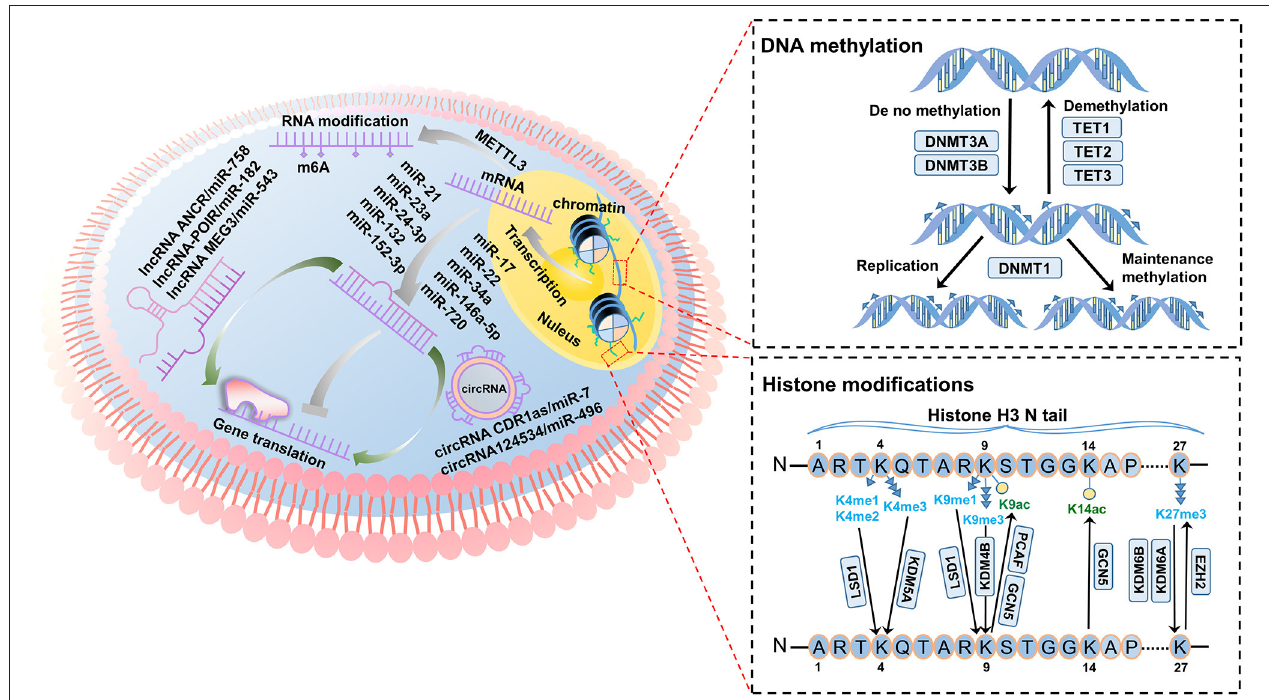
FIGURE 1 | Overview of the principal epigenetic modifiers in the regulation of dental stem cells (DSCs). DNA methylation: DNMT3A and DNMT3B modify unmethylated double strands of DNA in DSCs, while TETs remove methyl groups from DNA. DNMT1 is responsible for the maintenance of methylation levels of DSCs. Histone modifications: KDMs remove methyl groups from lysine mediated by LSD1, KDM4B, KDM5A, KDM6A, and KDM6B in DSCs. Histone acetylation (K9ac and K14ac) is regulated by HATs (PCAF and GCN5) in DSCs. Non-coding RNAs: In the epigenetic regulation of DSC fate, non-coding RNAs are of great importance. miR-17, miR-22, miR-34a, miR-146a-5p, and miR-720 promote DSC differentiation, while miR-21, miR-23a, miR-24-3p, miR-132 and miR-152-3p inhibit DSC differentiation. LncRNAs and circRNAs act as competing endogenous RNAs for miRNAs, constituting a complex regulatory network. LncRNA-POIR,